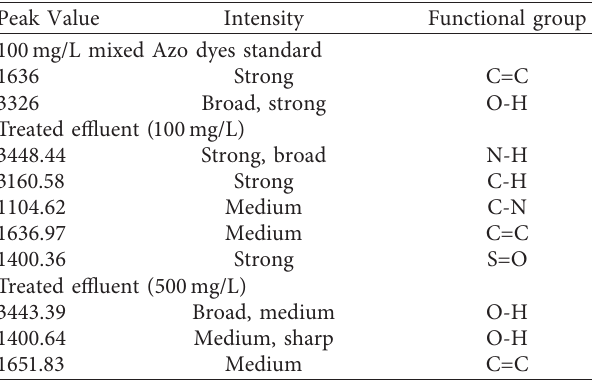
Table 2: Functional groups and compounds observed through FT- IR